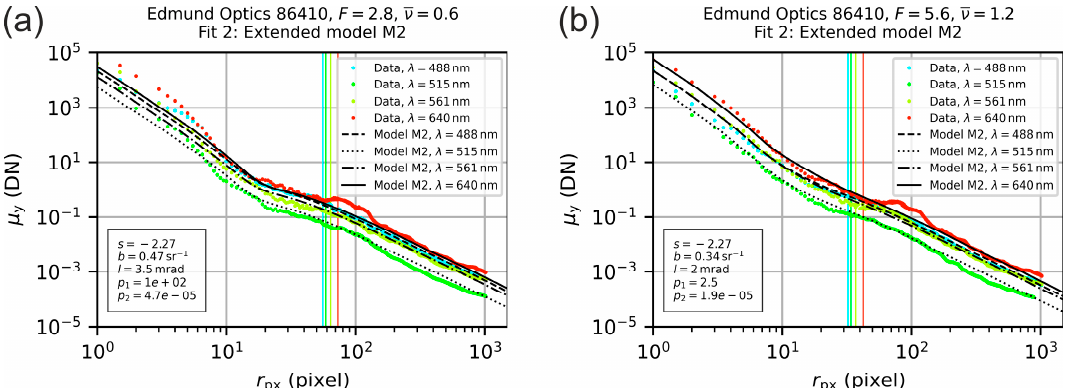
Figure 14. Radial irradiance distribution for the lens Edmund Optics 86410 operated with an f-number of ( a ) 𝐹 = 2.8 and ( b ) 𝐹 = 5.6 . The colored points are the measured values derived from the analysis of the camera images. The lines are the result of fitting the theoretical model M2 to the data.